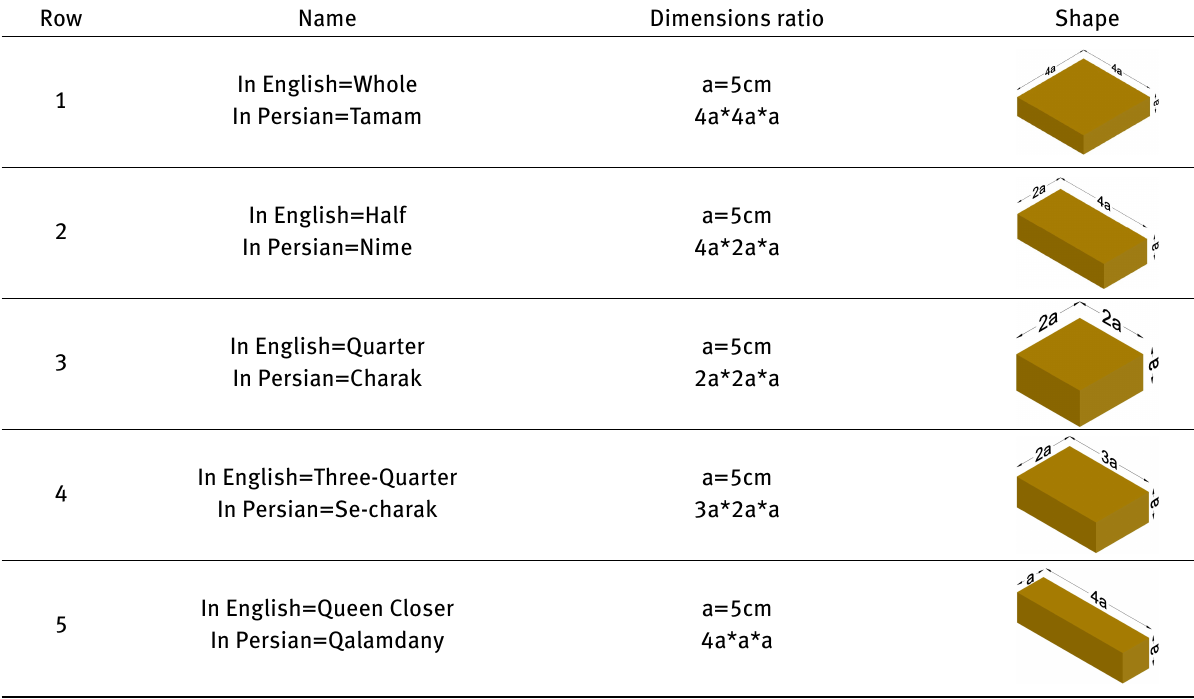
Table A1: Formation of different types of brick with different dimensions obtained from complete square-shaped brick